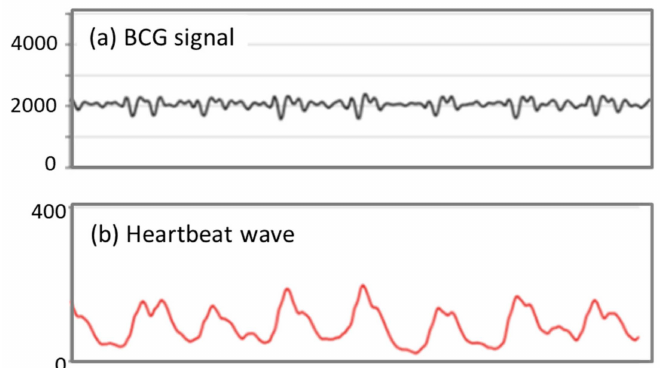
Figure 4. ( a ) Raw ballistocardiography (BCG) signals from an electromechanical film sensor (EMFi), and ( b ) a heartbeat wave extracted by the mean absolute deviation (MAD) algorithm from the BCG